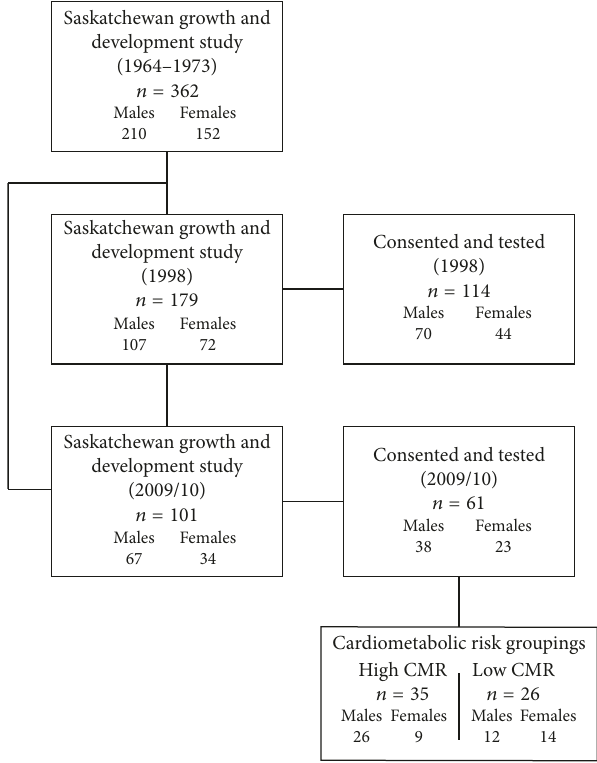
Figure 1: Participant numbers for the Saskatchewan Growth and Development Study and follow-ups in 1998 and